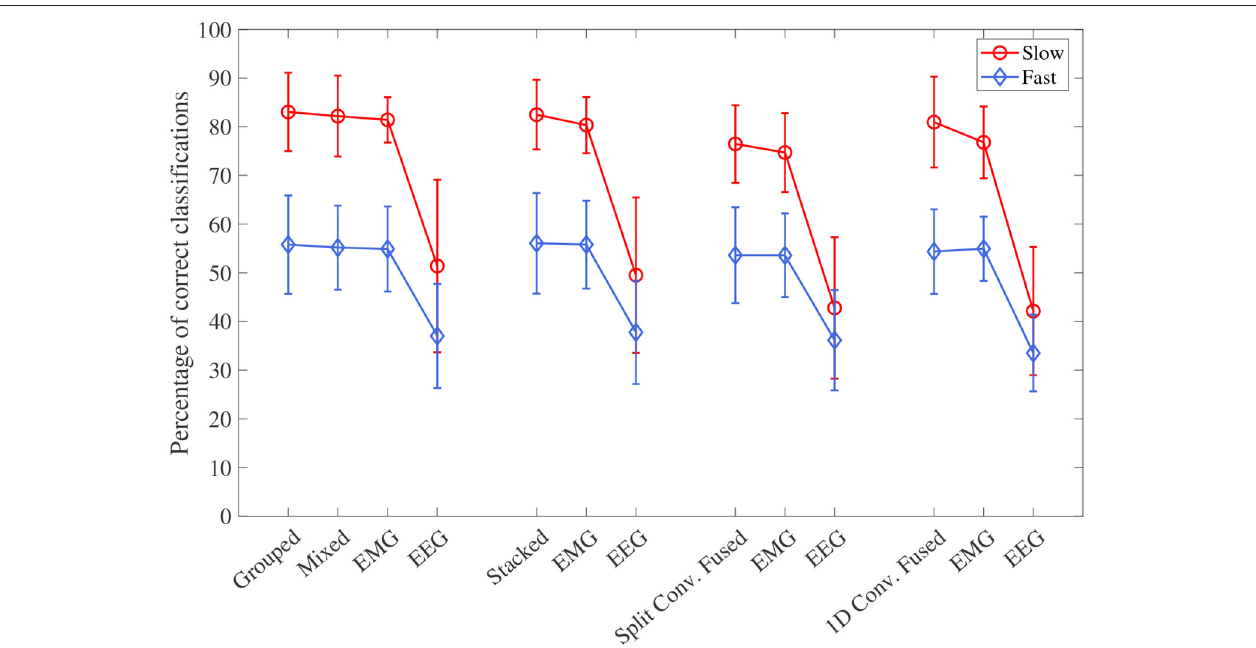
FIGURE 8 | The mean accuracy for all CNN models, separated by the two speed levels (fast and slow). Models of the same type are grouped together, with the order of the groups from left to right as follows: single-channel spectrogram models, multi-channel spectrogram models, split convolution signal models, and 1D convolution signal models. Error bars represent ± one standard